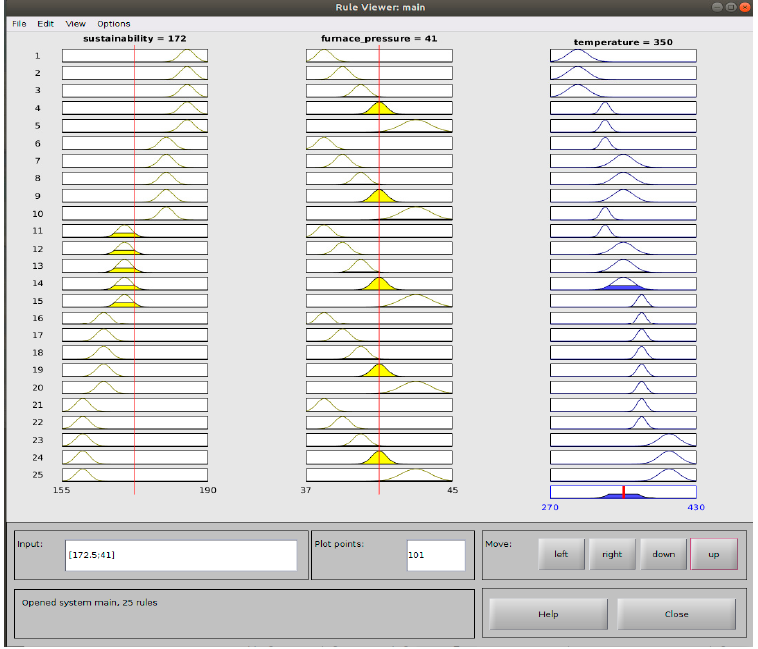
Figure 6. Visualization fuzzy inference in RuleViewer.